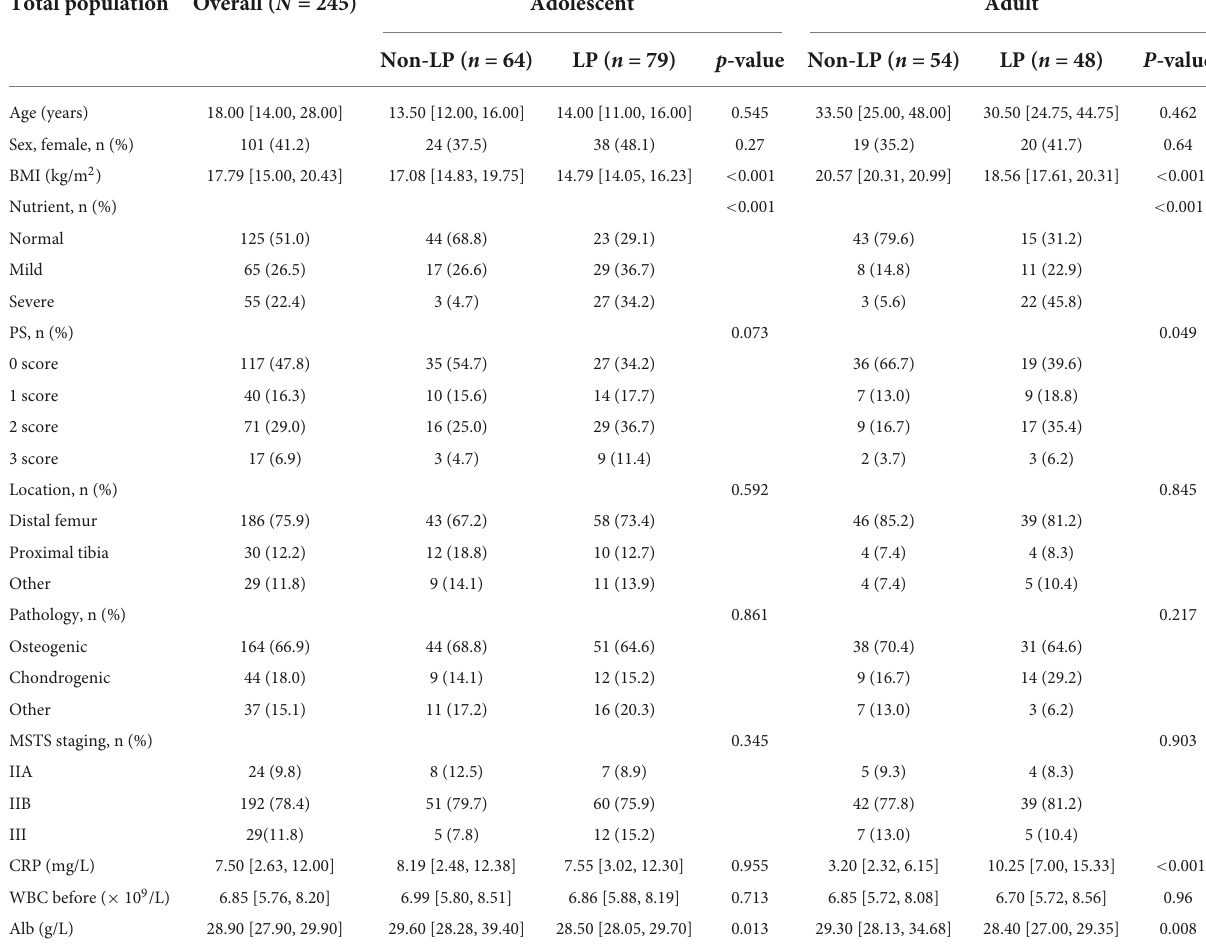
TABLE 1 Comparison between the leucopenia profiles on socio-demographics, clinical, pathologic and nutrient in different population. Total population Overall ( N = 245)